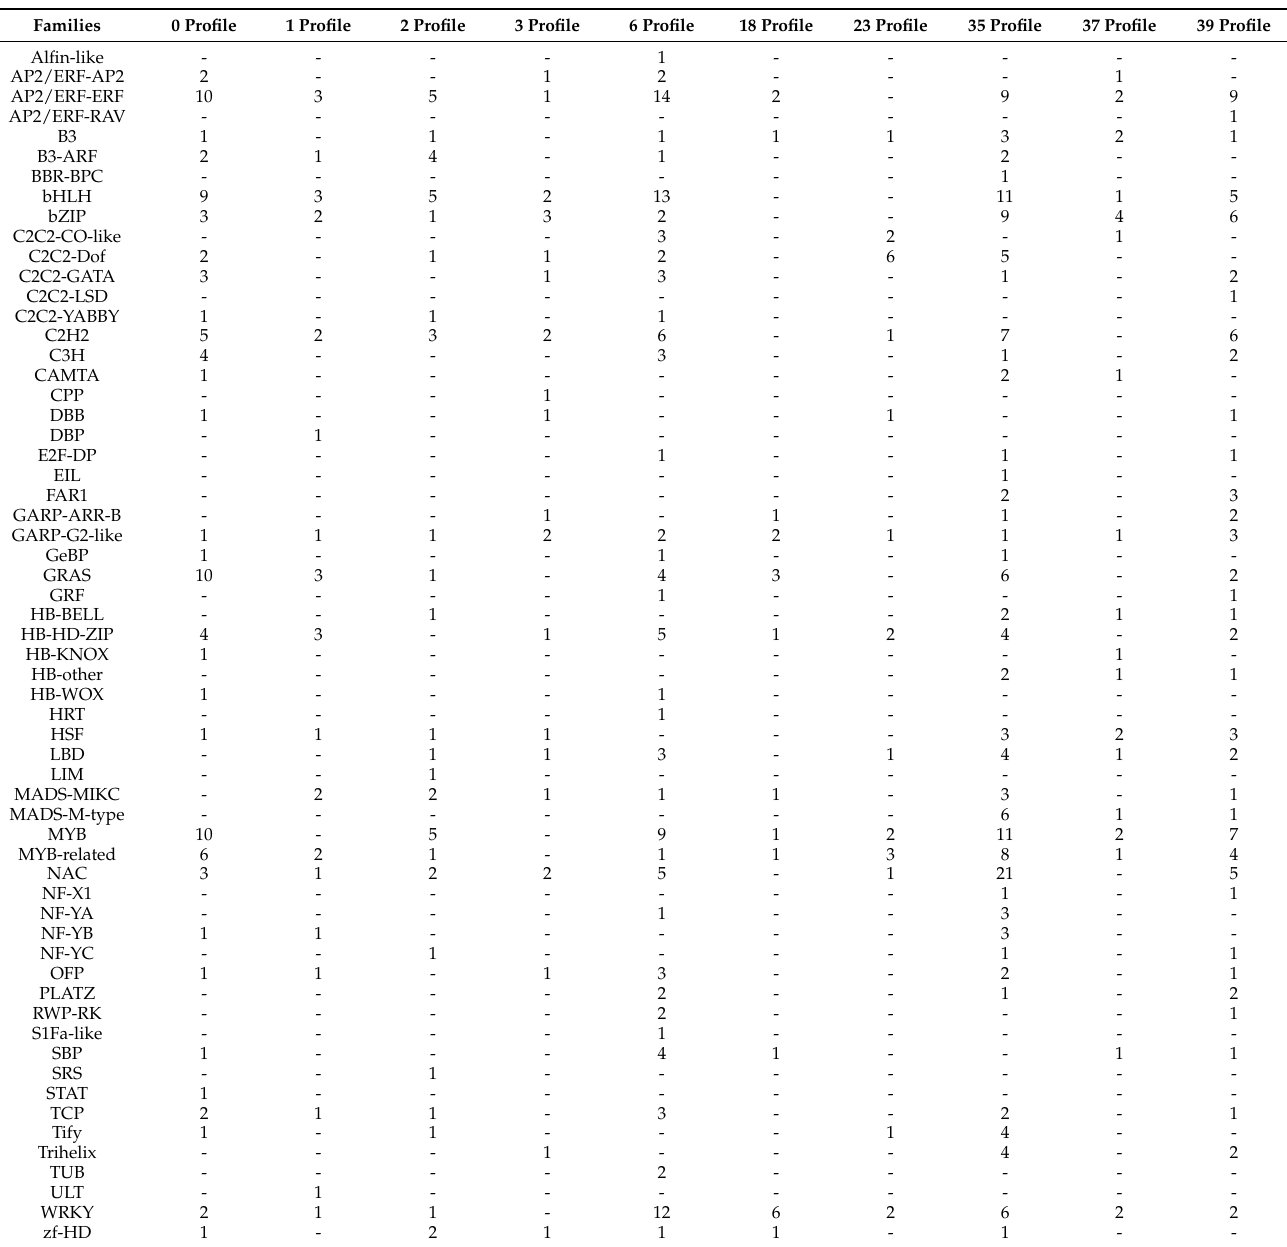
Table 2. Transcription factors’ families with distinct expression kinetics during dark-induced senes- cence, identified via STEM